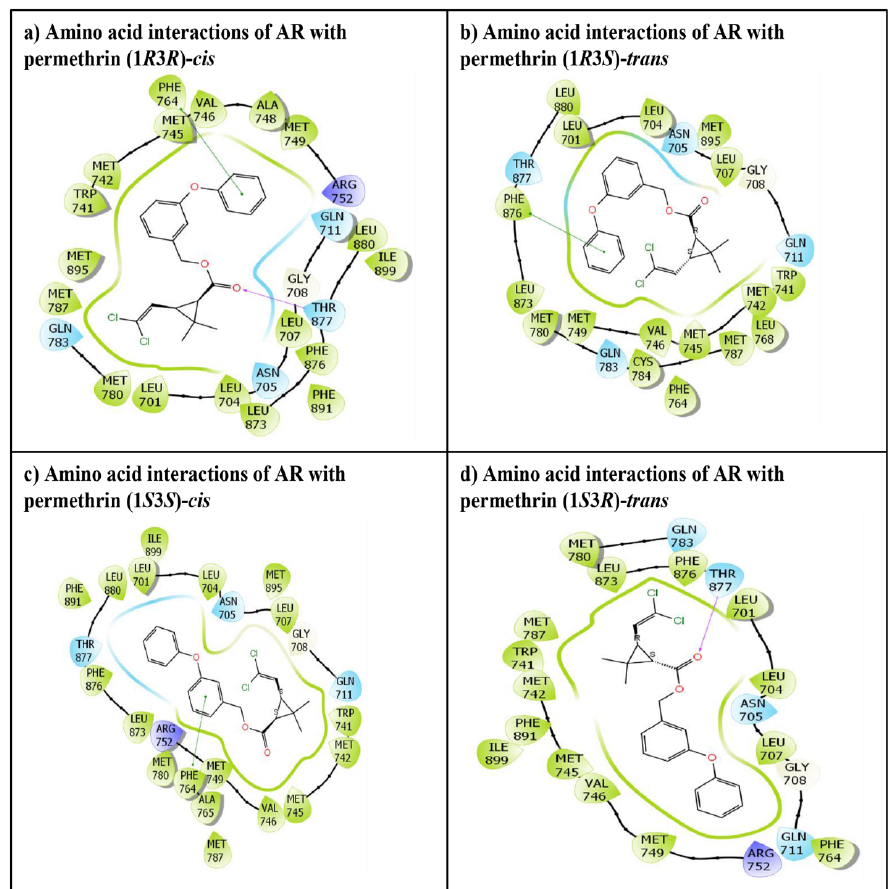
Figure 2. The amino acid residue interactions of the four stereoisomers of permethrin in the ligand binding pocket of the AR: ( a ) permethrin (1 R 3 R )- cis , ( b ) permethrin (1 R 3 S )- trans , ( c ) permethrin (1 S 3 S )- cis , and ( d ) permethrin (1 S 3 R )- trans . The cyan colored amino acids lining the ligand binding pocket represent polar residues. The green colored amino acid residues represent hydrophobic residues, and the purple colored amino acids represent positively charged residues. The red colored arrows indicate hydrogen bonding interactions, and the green colored lines indicate pi–pi interaction between the ligand and receptor amino acid residues.